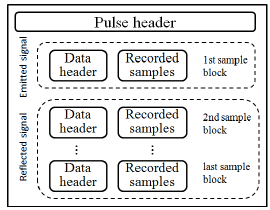
Figure 2. Structure of Pulse record